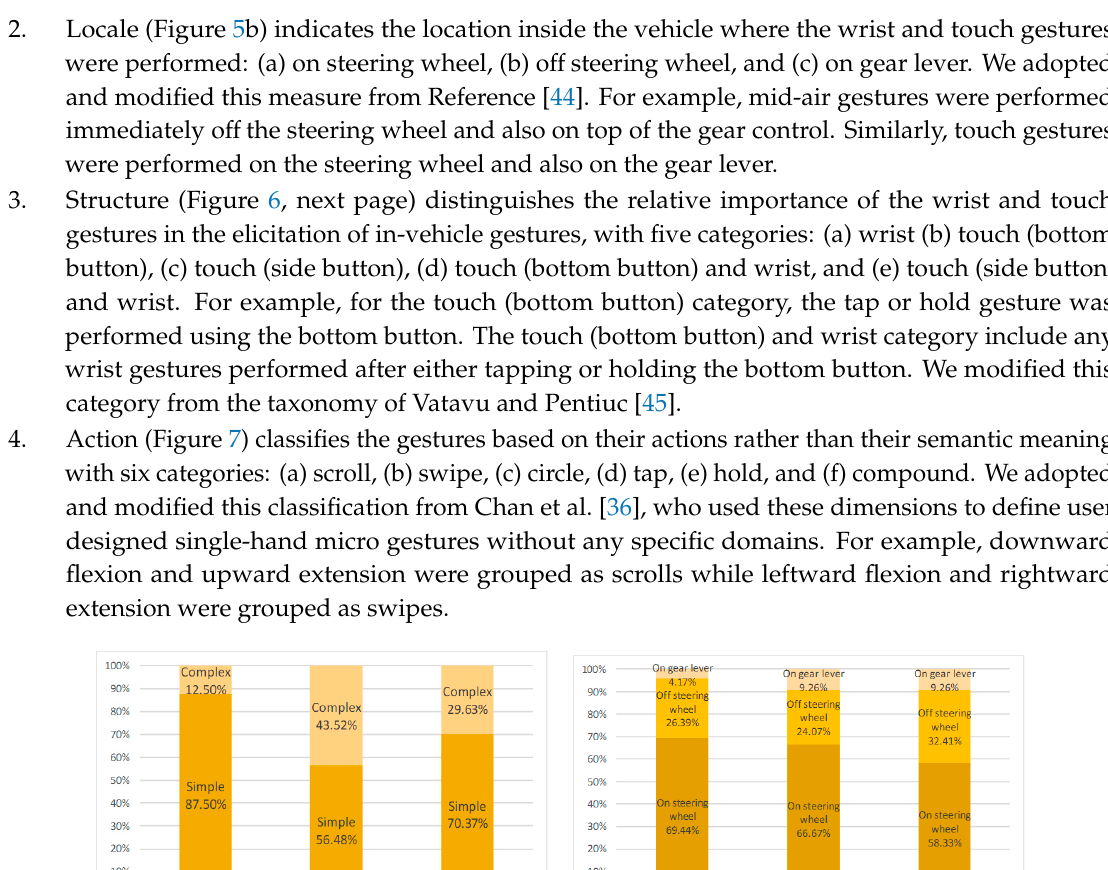
Figure 7. Frequency distribution of actions used for each command in the preferred gesture set. Scrolls were highly preferred for commands move up and down. Simple gestures were highly preferred for the commands in all three categories. Interestingly, the drivers preferred to distinguish commands using two different simple gestures (touch and wrist). 45.84% of touch gestures (compared to 41.66%) were preferred for the commands in the phone category, while wrist gestures (45.37% compared to 25%) were reserved for the music player. Unsurprisingly, 32.41% of wrist gestures were performed off the steering wheel for the commands in the music player category. Complex gestures (map navigation: 43.52%; music player: 29.63%; phone: 12.50%) were highly preferred for the commands in the map navigation category. Particularly, the bottom button was preferred to perform both simple (phone: 29.17% vs 16.67%) and complex gestures (map navigation: 37.96% compared to 5.56%). Only 7.99% of gestures were performed on gear lever. 64.81% of gestures were performed on the steering wheel. Out of this, nearly 3.5% gestures were performed while holding the steering wheel. 27.78% of mid-air gestures were performed in very close proximity to the steering wheel, while nearly 8% were performed on the gear lever. These